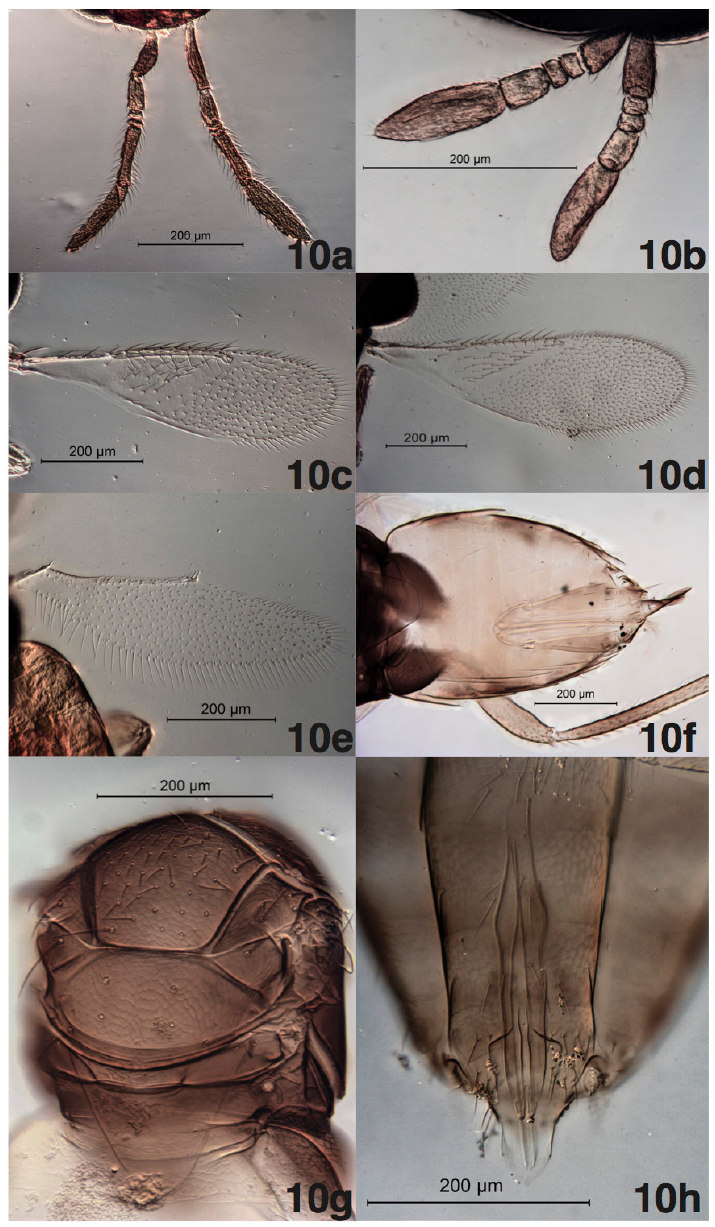
Figure 10. Aphelinus sinensis n.sp., slide-mounted paratypes 10a male, antenna, lateral view (TAMU- ENTO X0852885) 10b female, antenna, lateral view (TAMU-ENTO X0852877) 10c male, fore wing, dorsal view (TAMU-ENTO X0852885) 10d female, fore wing, dorsal view (TAMU-ENTO X0852875) 10e female, hind wing, dorsal view (TAMU-ENTO X0852869) 10f female, metasoma, ventral view (TAMU-ENTO X0852880) 10g female, mesosoma, dorsal view (TAMU-ENTO X0852880) 10h male, genitalia, ventral view (TAMU-ENTO